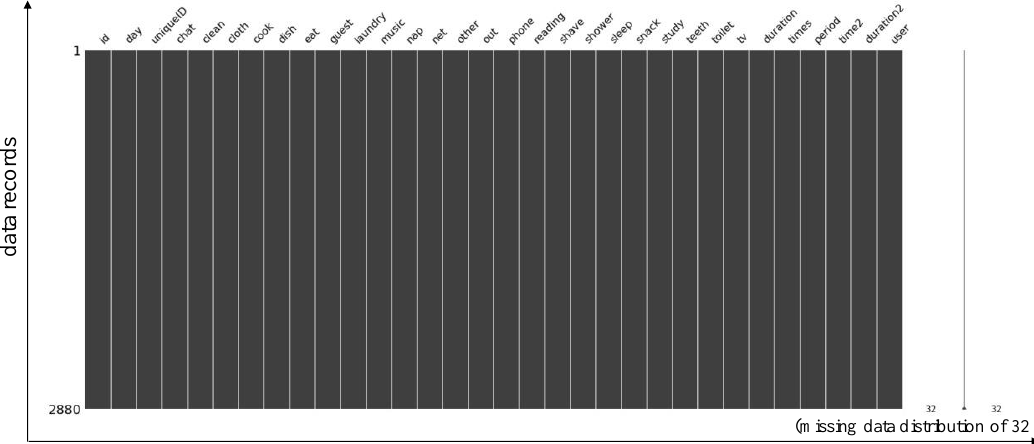
Figure 1. Data Figure 1. Data visualization.